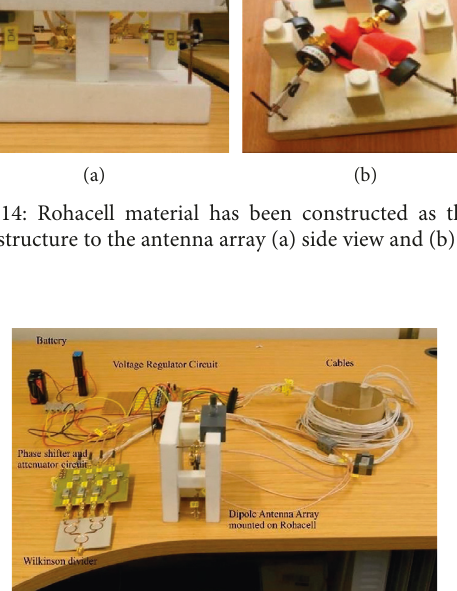
Figure 17: Output phase, ø p, of each channel when V pp varies from 0–15V and V aq is kept constant.